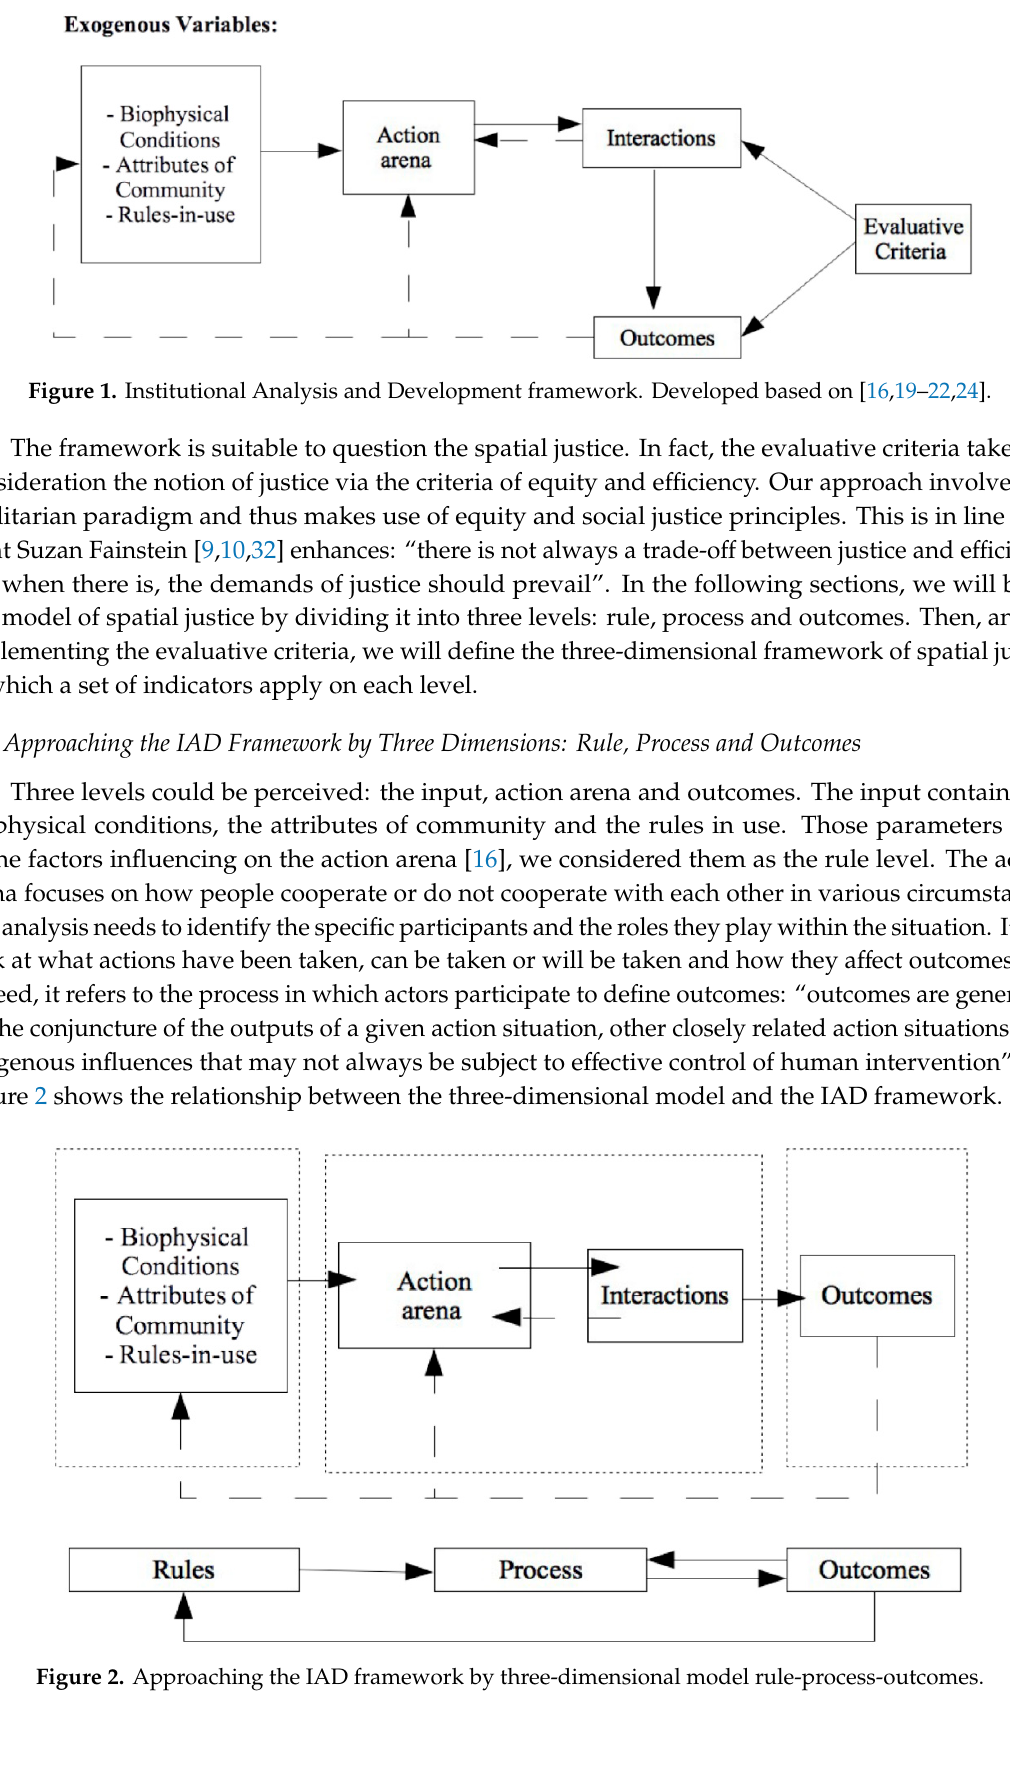
Figure 1. Institutional Analysis and Development framework. Developed based on [16,19–22,24].